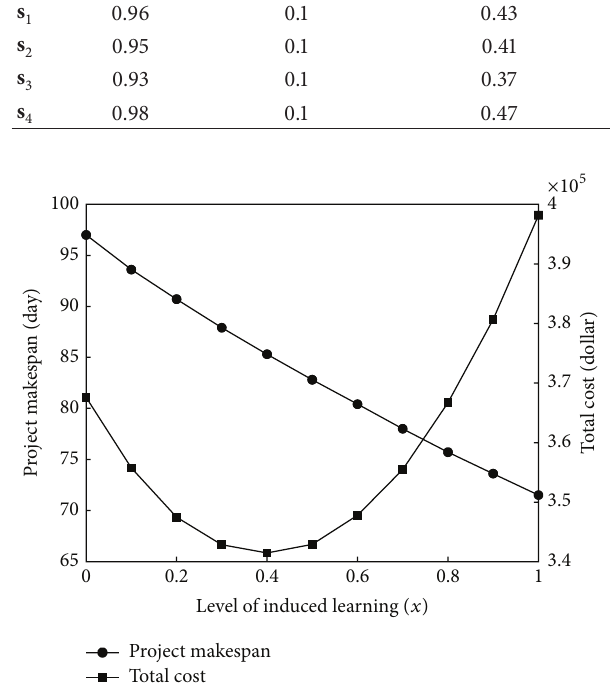
Figure 2: Project makespan-induced learning and total cost- induced learning